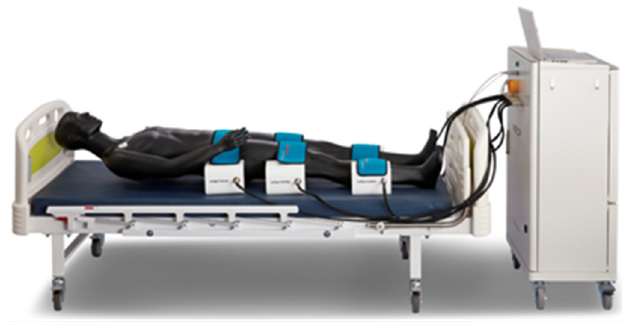
Figure 2. Medical electric leg compression machine.